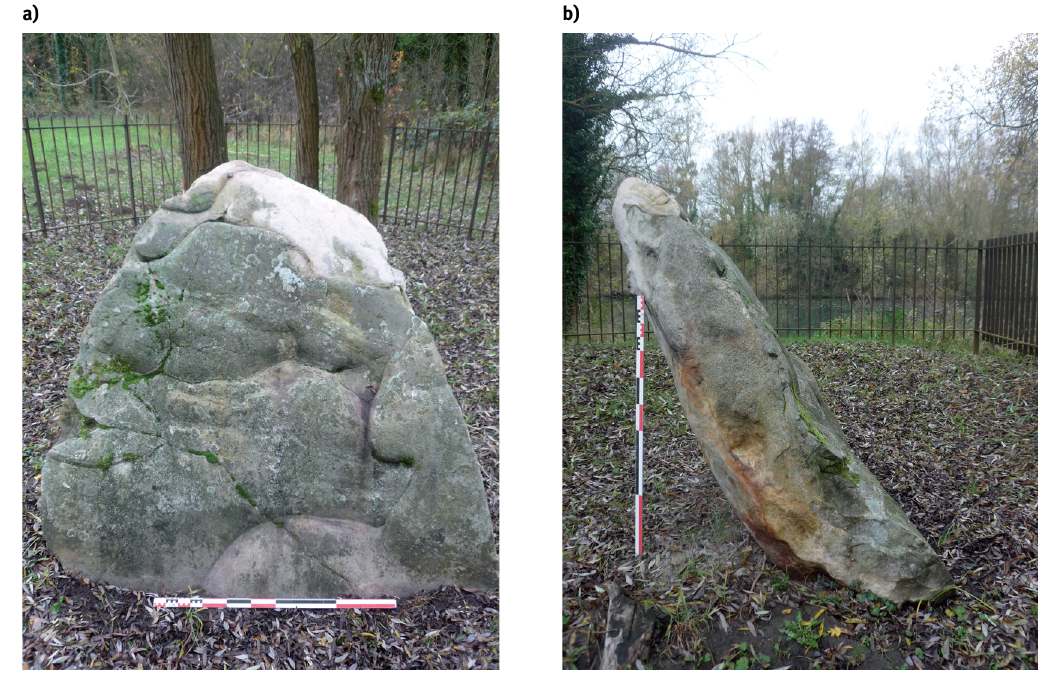
Figure 15. The Pierre Beaumirault (Bruyères-le-Châtel/Essonne): front and side views. © J.